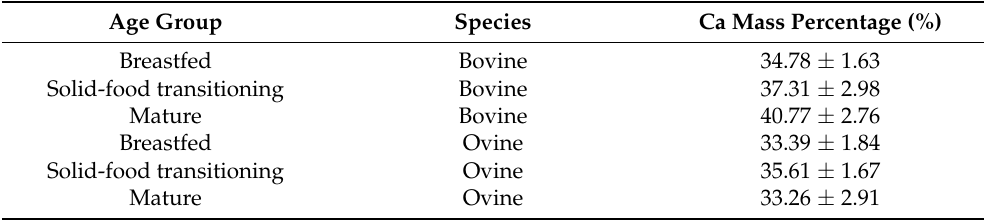
Figure 2. Calcium mass percentages reported with EDX analysis with their respective standard de- viations. Bovine specimens are shown with red bars, whereas ovine specimens are colored blue. SFT refers to solid-food transitioning specimens.